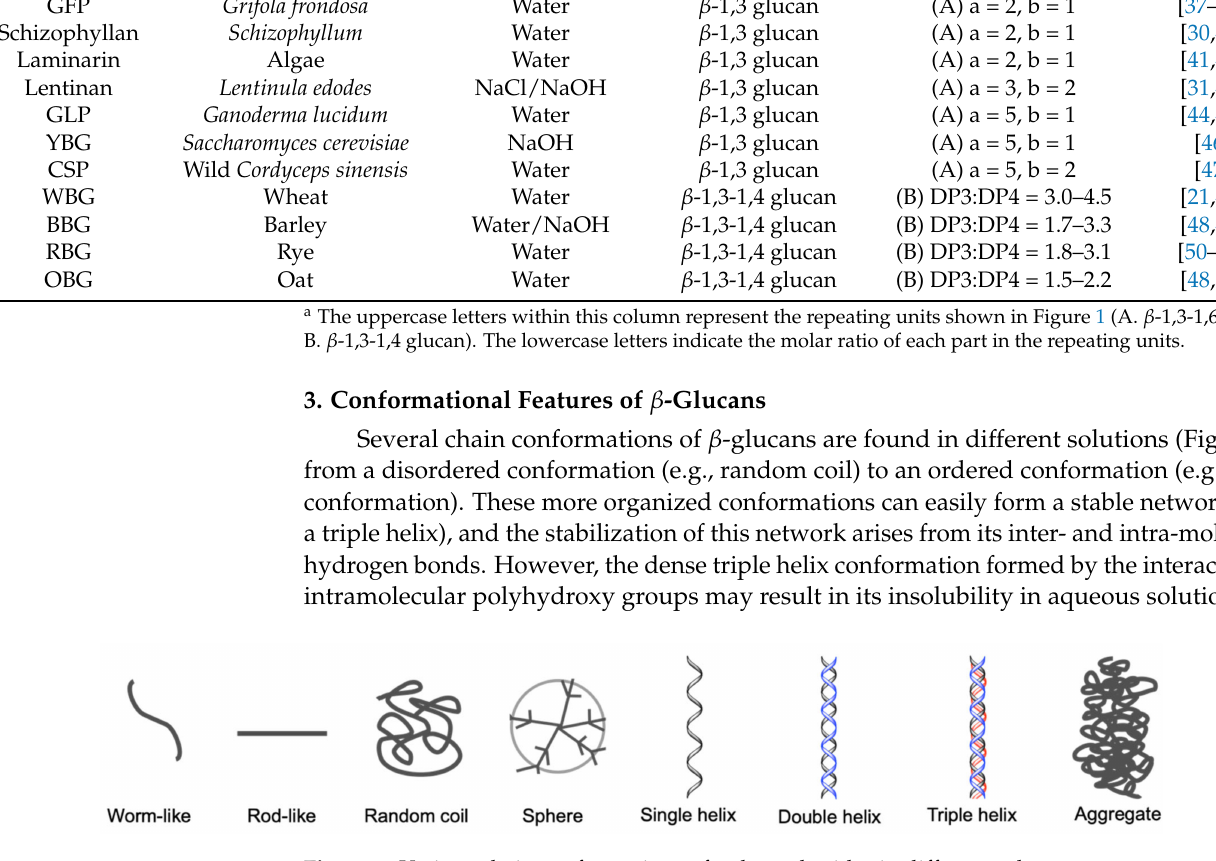
Figure 2. Various chain conformations of polysaccharides in different